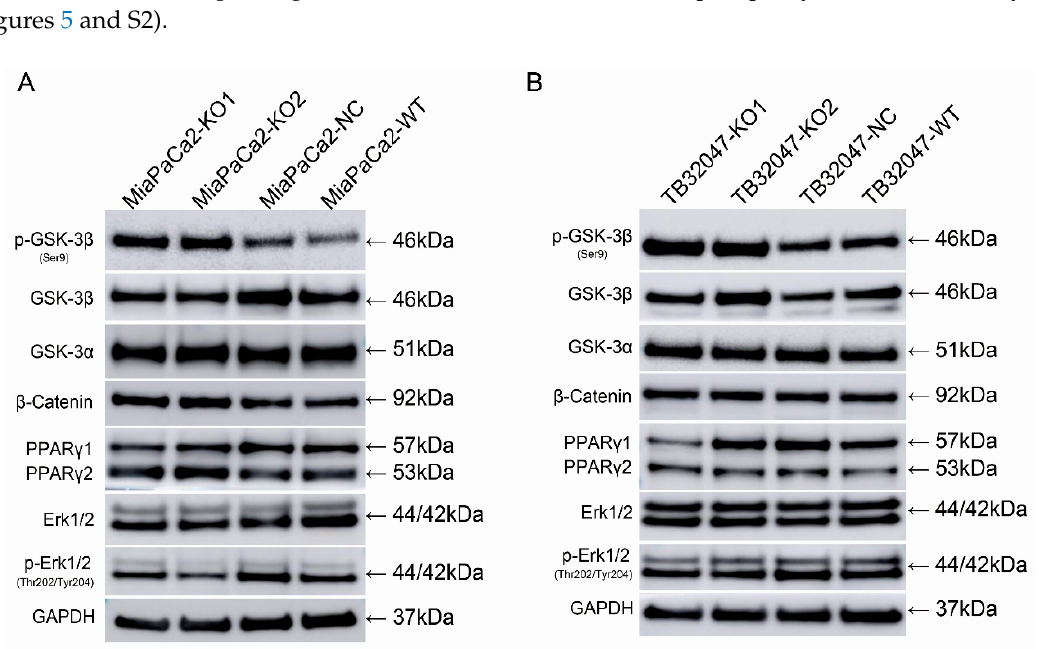
Figure 4. Knockout of GPRC5a suppressed chemotherapy drugs resistance in MIA PaCa-2 and TB32047 cells. ( A – C ) shows the EC50 (Concentration for 50% of maximal effect) assay of gemcitabine, oxaliplatin, and fluorouracil in the MIA PcCa-2 cell line. ( D – F ) shows the same results in the TB32047 cell line.